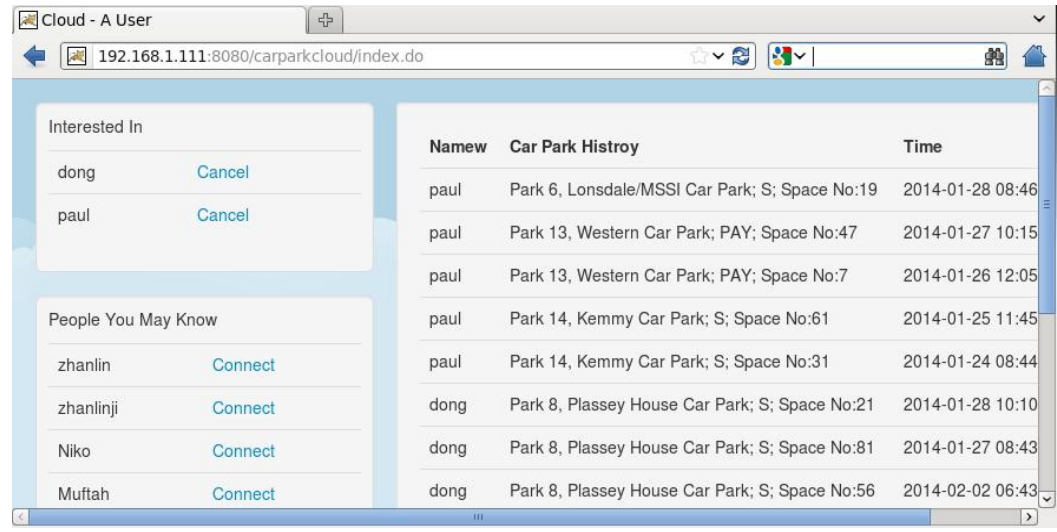
Figure 16. A sample car-parking usage history GUI in the cloud tier.